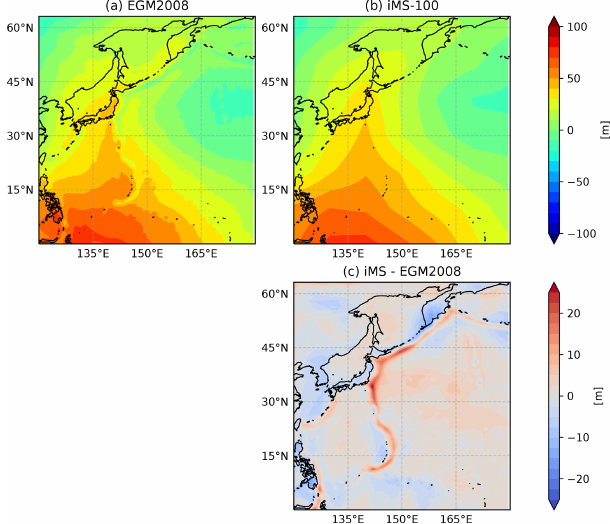
Figure 7. (a) Geoid height for iMS-100-GDP (EGM2008; 5 (cid:48) × 5 (cid:48) ), (b) iMS-100 original (10 ◦ × 10 ◦ ), and (c) the difference (northwest- ern Pacific